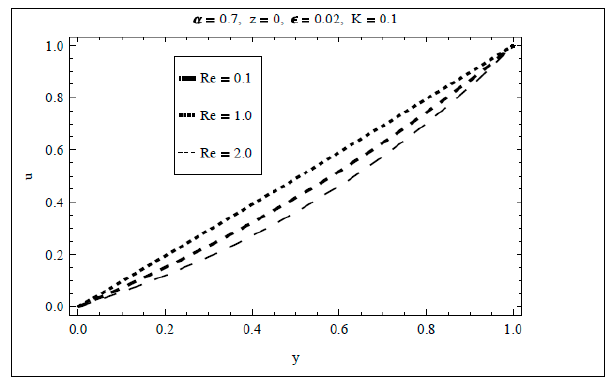
Figure 4. E ff ect of Re on main flow velocity u along y Figure 4. Effect of Re on main flow velocity u along y . Figure 4. Effect of Re on main flow velocity u along y . Figure 4. Effect of Re on main flow velocity u along y .